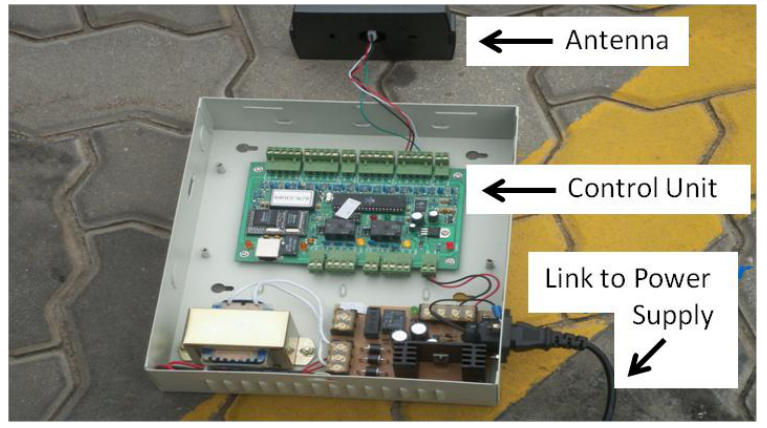
Figure 3. Architecture of RFID